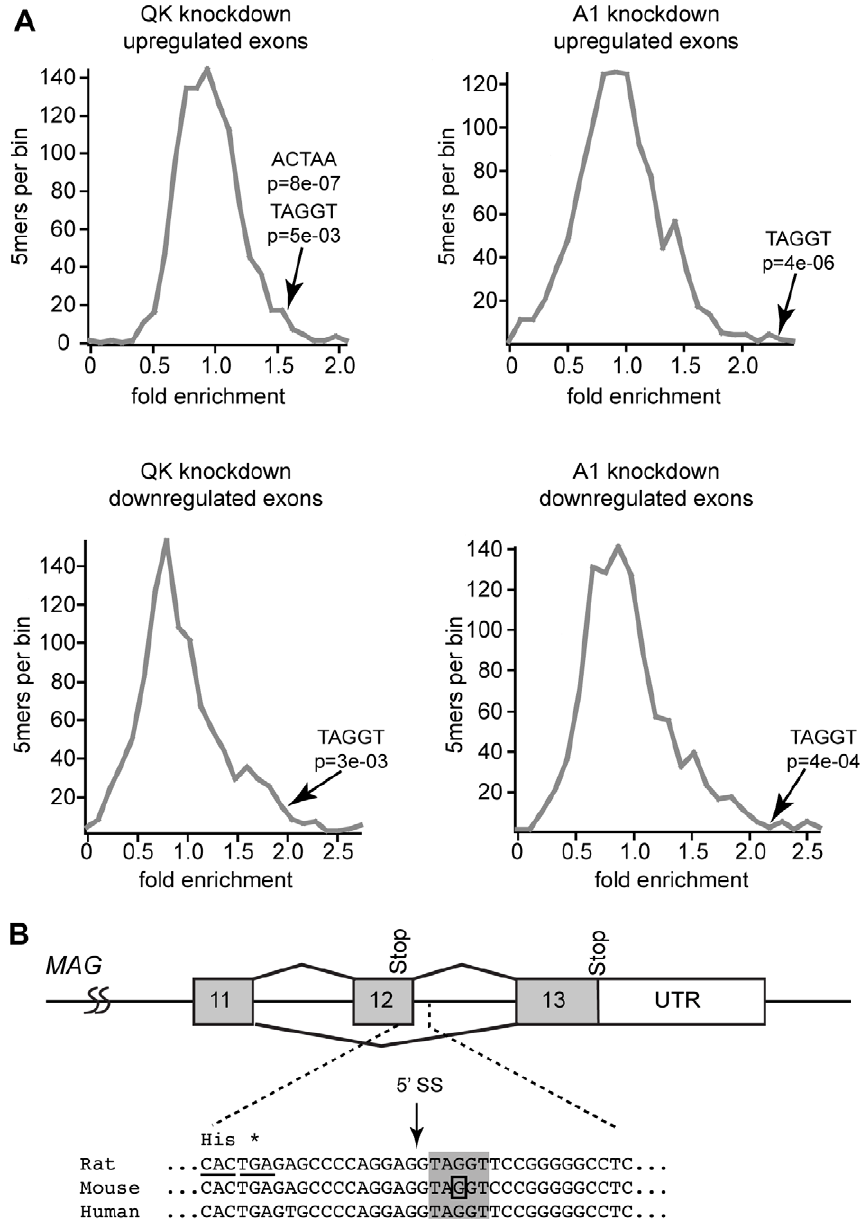
Figure 8. hnRNP A1 motifs are enriched in QK-responsive exons. (A) Relative 5mer frequencies in exons that change in response to QK or hnRNP A1 knockdown were binned according to fold enrichment compared to frequency in all exons. The position of hnRNP A1 and QK motifs is annotated by an arrow. The significance of the enrichment was determined by comparison to 5mer fold enrichment in ten groups of an equivalent number of exons selected at random. (B) An hnRNP A1 motif (gray box) is present in Mag intron 12 immediately downstream of the 5 9 -splice site (arrow). The position of the mutation that causes constitutive Mag exon 12 inclusion is boxed [14].